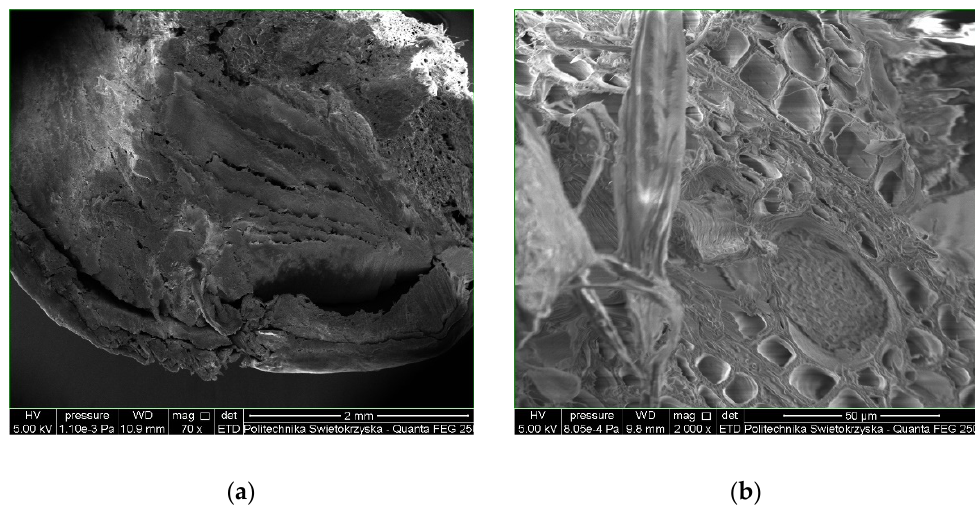
Figure 13. Scanning electron microscope (SEM) images of wood: ( a ) wet wood, horizontal cross section, magnification 70×; and ( b ) wet wood, vertical section, magnification 2 × 10 3 .